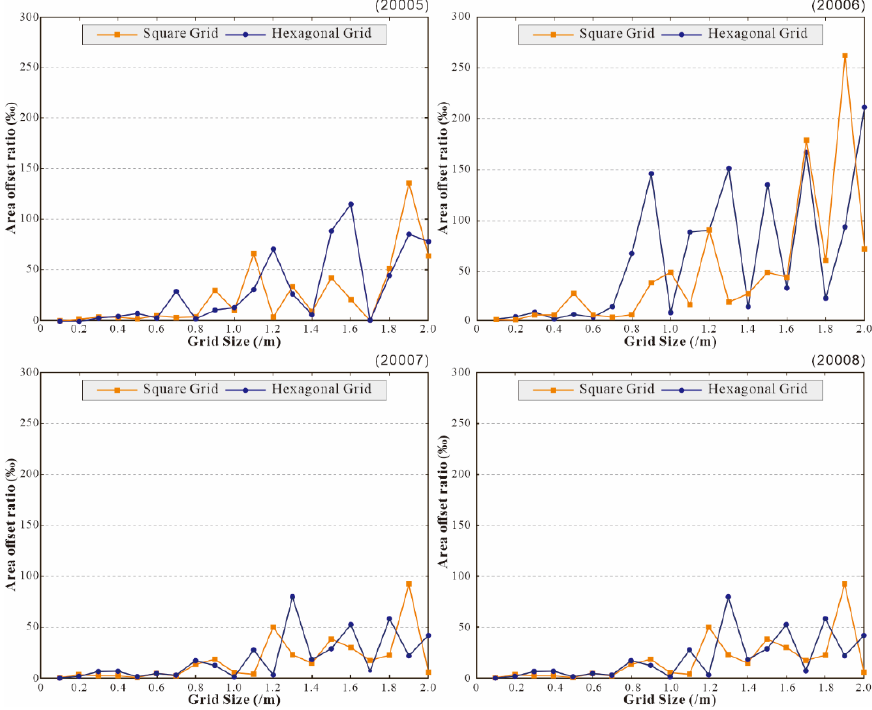
Figure 16. Diagram of the deviation from the true value of the small experimental areas